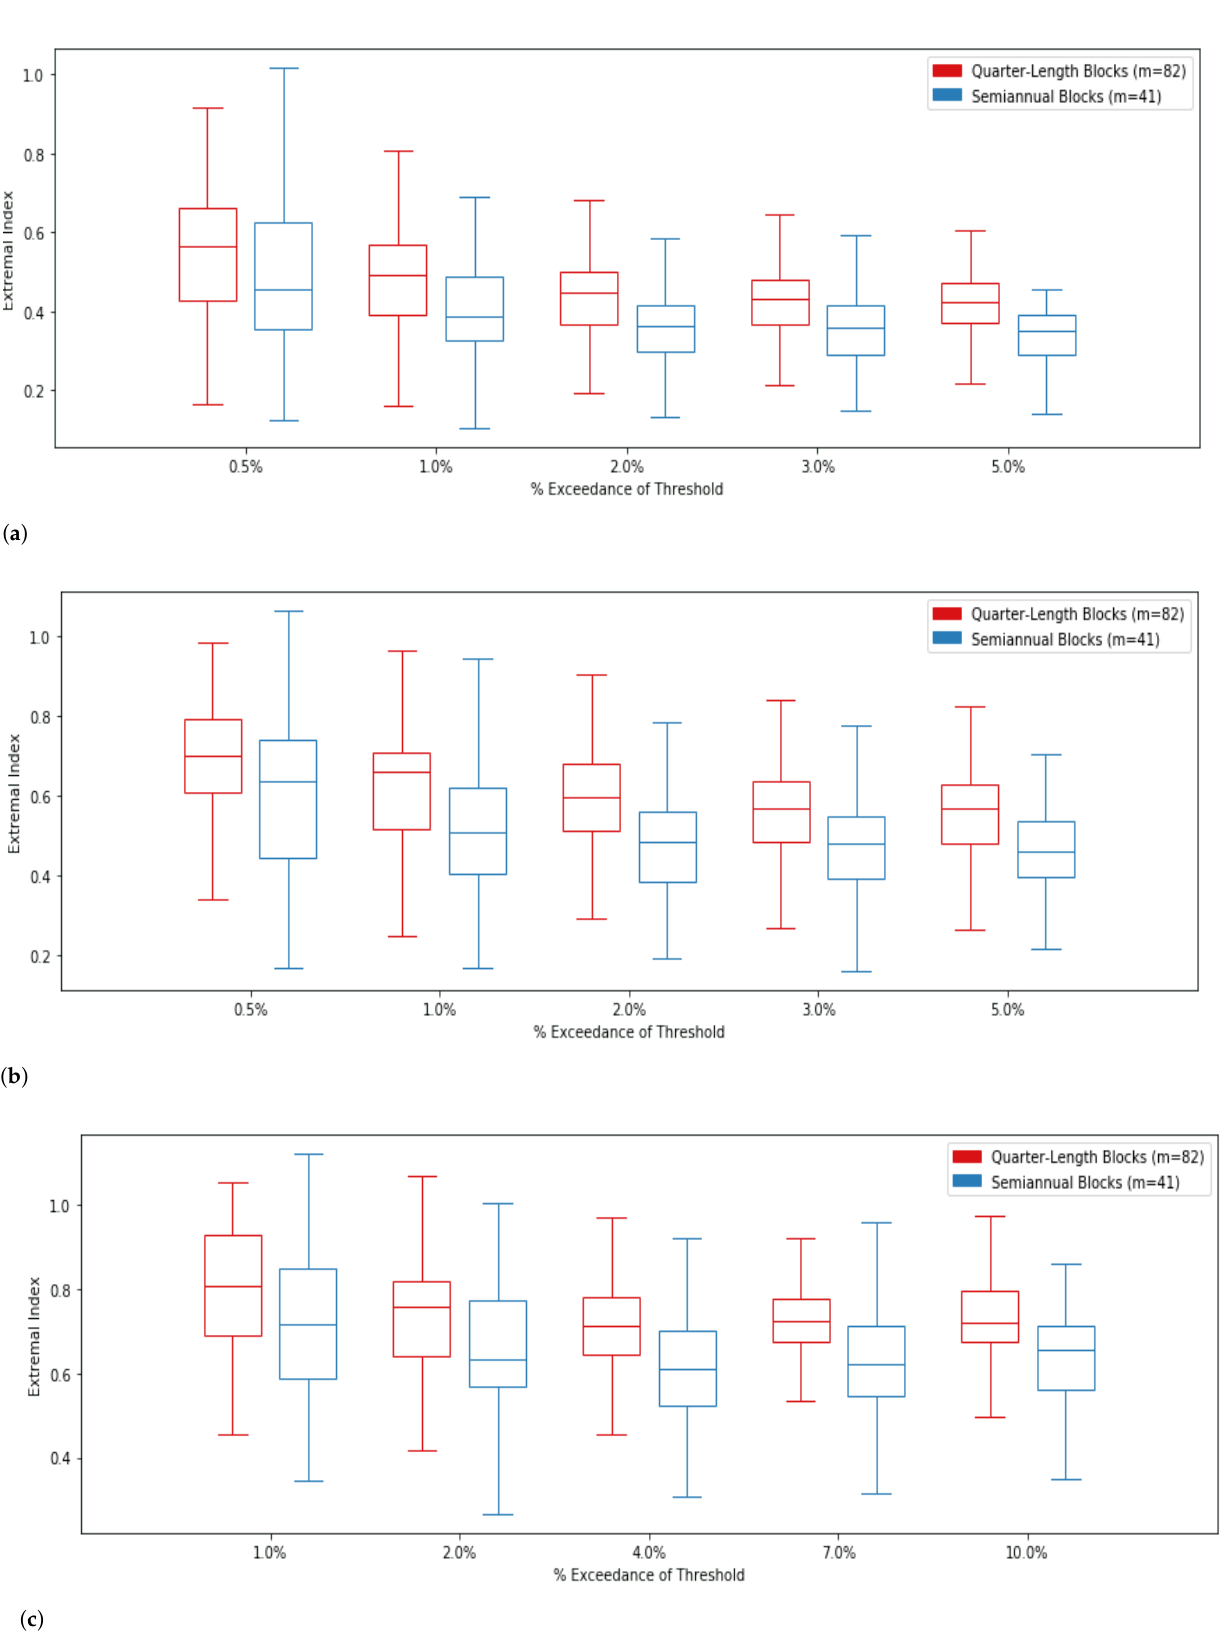
Figure 1. Estimates of extremal index for stock losses with different frequencies. ( a ) Daily losses; ( b ) alternate-day losses; ( c ) weekly